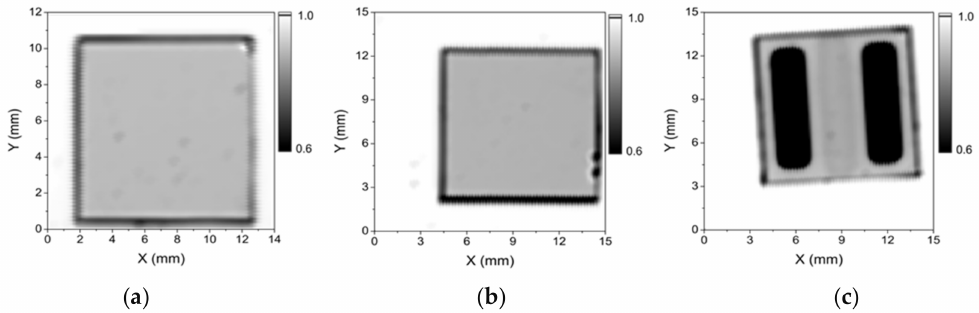
Figure 4. White-lightoptical-transmissionmapsof( a )2GML / glass; ( b )3GML / glass; ( c )TCEinconfiguration 2 (40-nm-thick AZO on 3 GML / glass, where the black zone corresponds to Ti / Ag metallization).